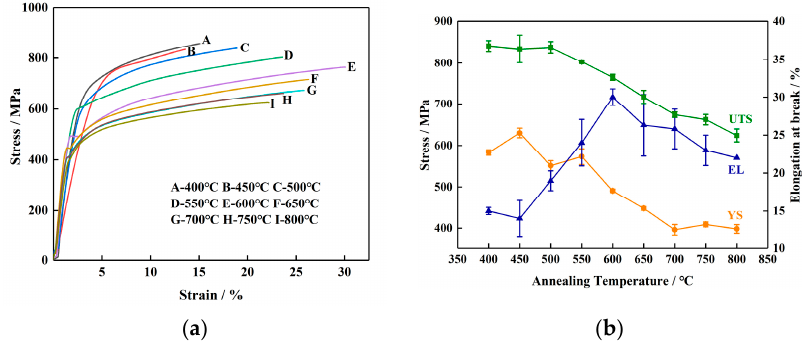
Figure 8. Tensile properties of Ti 50 Ni 47 Fe 3 alloy with different annealing treatments. ( a ) Stress-strain curves of Ti 50 Ni 47 Fe 3 SMA; and ( b ) the yield strength (YS), ultimate tensile strength (UTS) and elongation (EL) trends with the increase of annealing